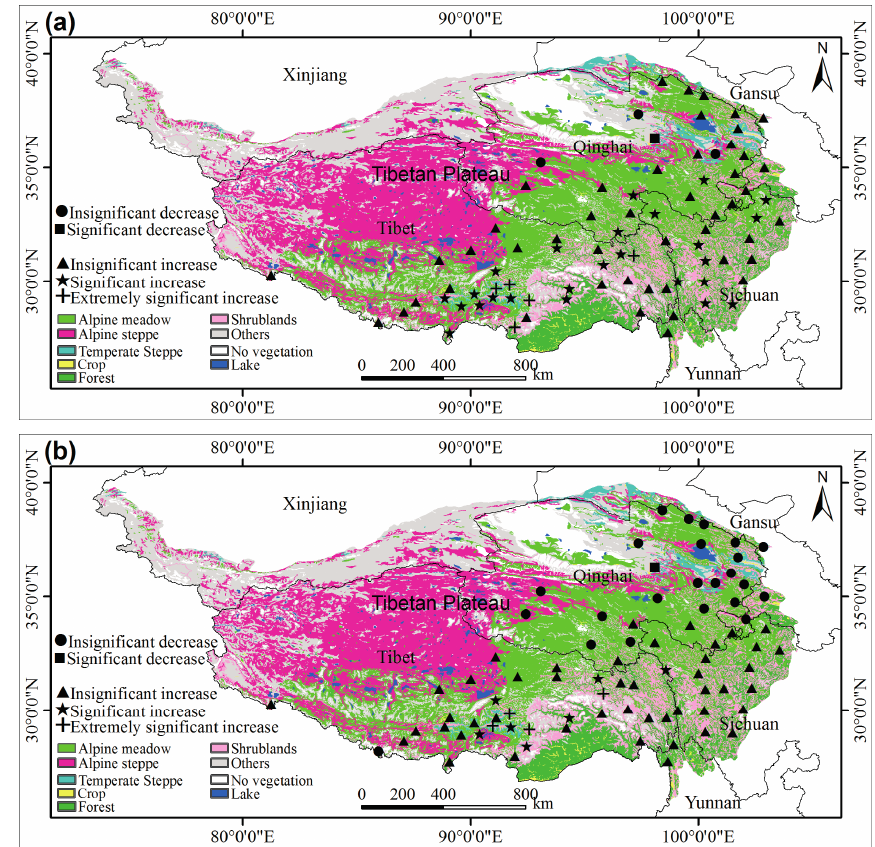
Figure 3. Trends for the growing season: ( a ) average temperature (GAT); ( b ) maximum temperature (GMAT); ( c ) minimum temperature (GMIT); ( d ) total precipitation (GTP); ( e ) maximum precipitation (GMAP); ( f ) average vapor pressure (GAE); ( g ) average relative humidity (GARH); ( h ) minimum relative humidity (GMIRH); and ( i ) average vapor pressure deficit (GAVPD); from 2000 to 2012 from 81 meteorological stations on the Tibetan